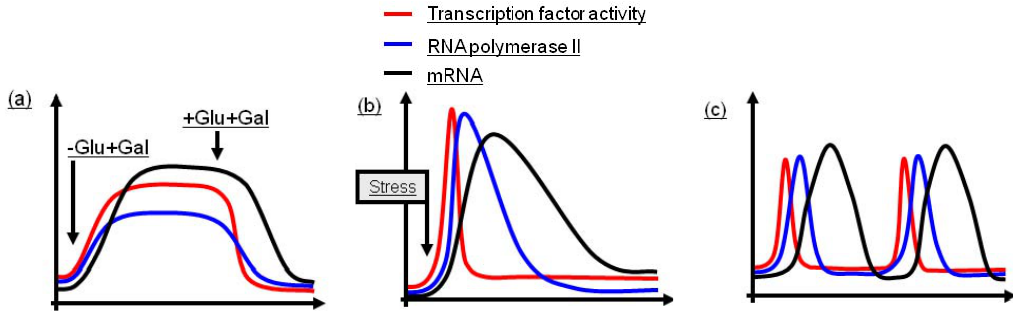
Figure 1. Patterns of induced transcription. ( a ) Sustained transcription is characterized by prolonged transcription factor activity depending on the induction signal resulting in moderate RNA Pol II association and sustained transcript levels; ( b ) During single pulse transcription intense transcription factor activity is followed by high RNA Pol II occupancy over a short period of time resulting in swift upregulation of transcripts and subsequent repression to basal levels; and ( c ) Oscillatory transcription appears as a circular pattern characterized by short and strong transcription factor activity as well as RNA Pol II binding. Transcripts are quickly and strongly upregulated following a harsh repression to basal